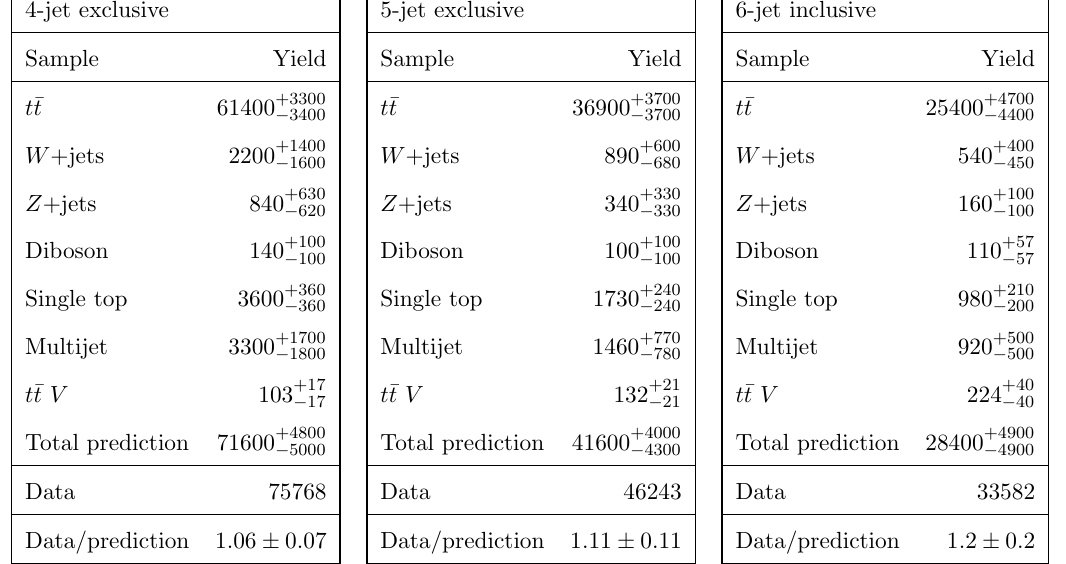
Table 2 . Event yields in the 4-jet exclusive (left), 5-jet exclusive (centre) and 6-jet inclusive (right) con(cid:12)gurations. The uncertainties include the combined statistical and systematic uncertainties, excluding the systematic uncertainties related to the modelling of the t (cid:22) t